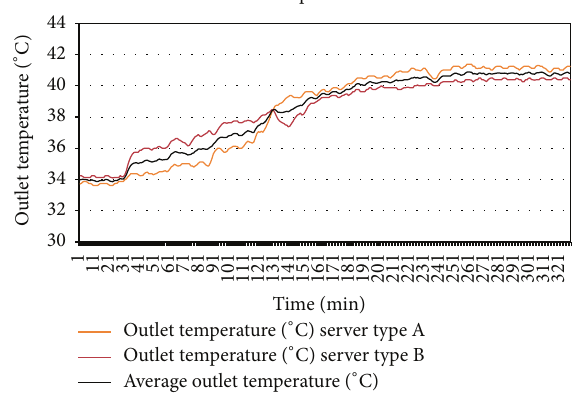
Figure 9: Outlet temperatures from SLI tests of the servers are more homogenous and close to average after